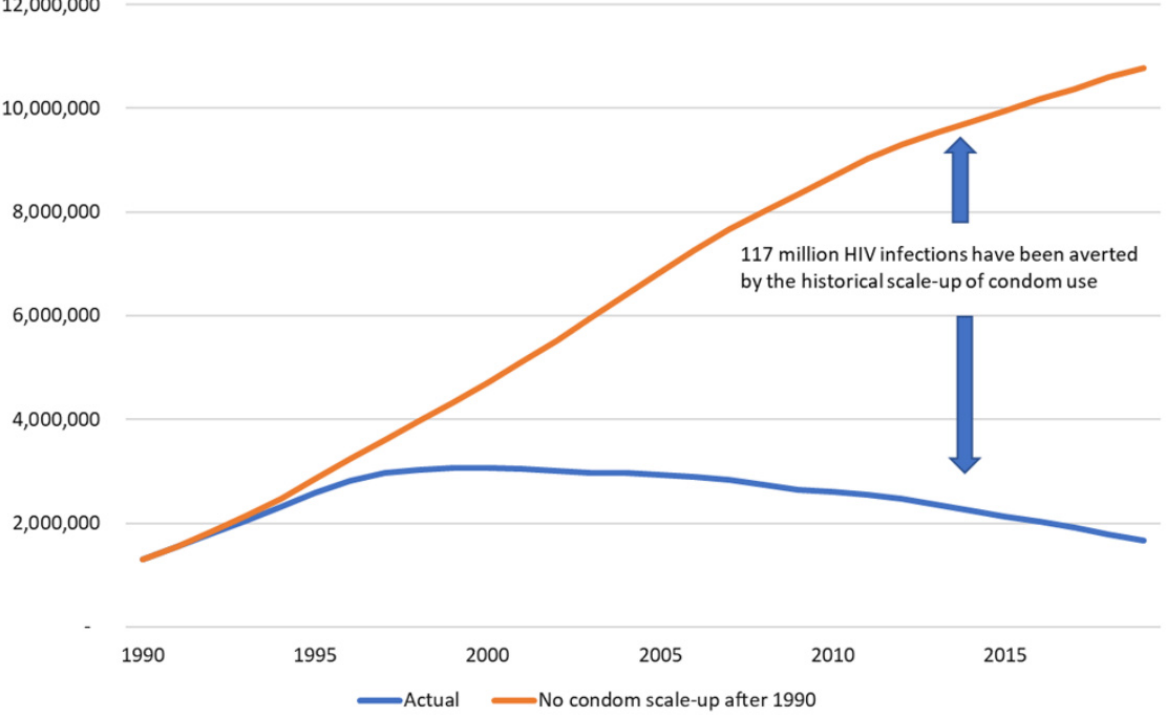
Figure 1. Number of new HIV infections with and without historical scale-up of condom